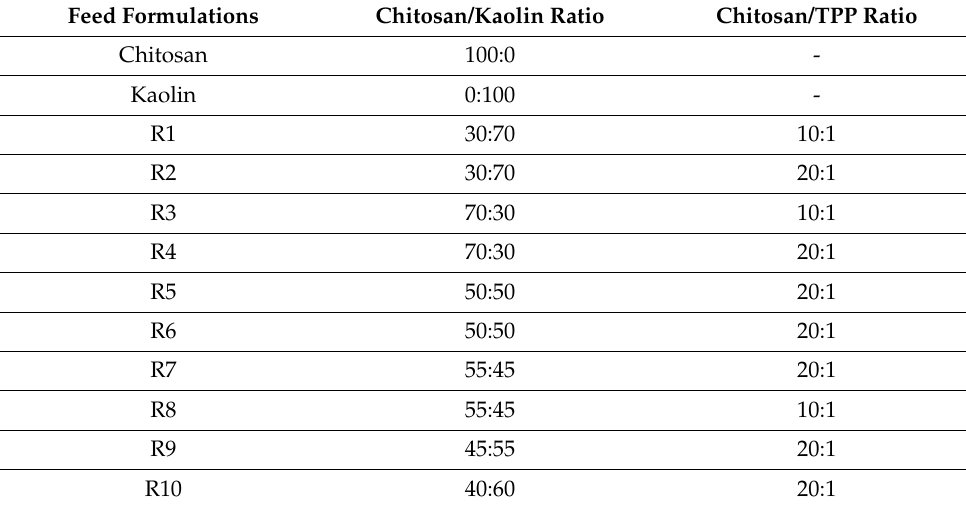
Table 1. Feed formulations used in the spray drying process. Feed